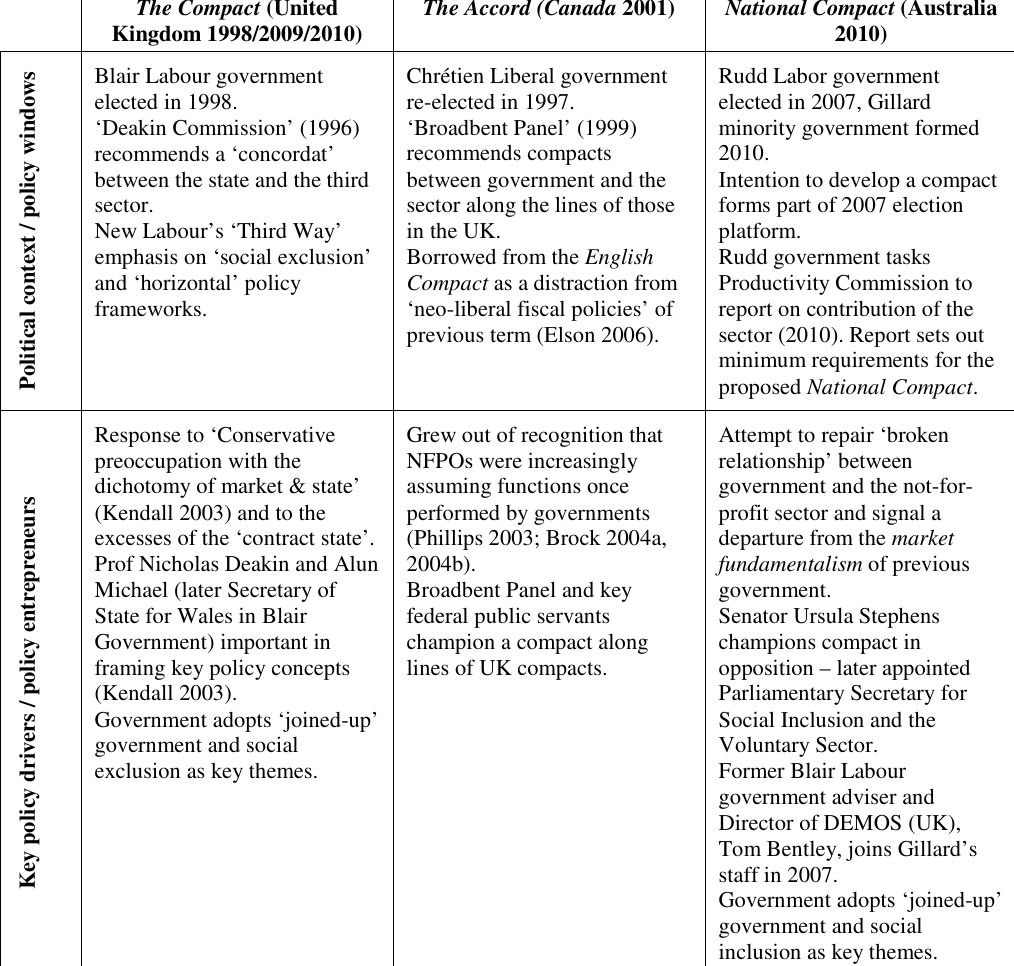
Table 1 — A Comparison of National Frameworks for Inter-sectoral